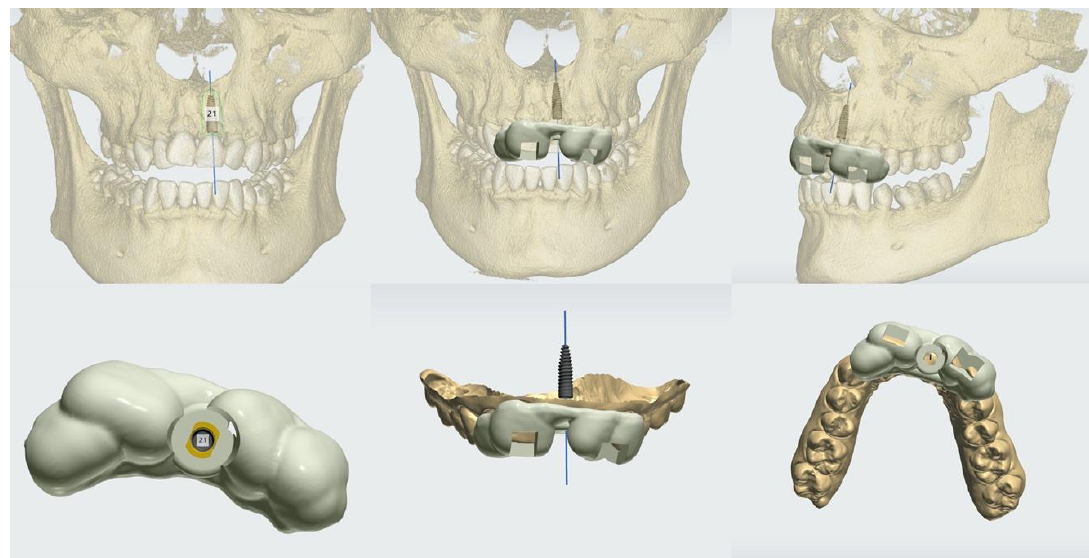
Figure 6. Digital planning of the surgical guide of Case 1.